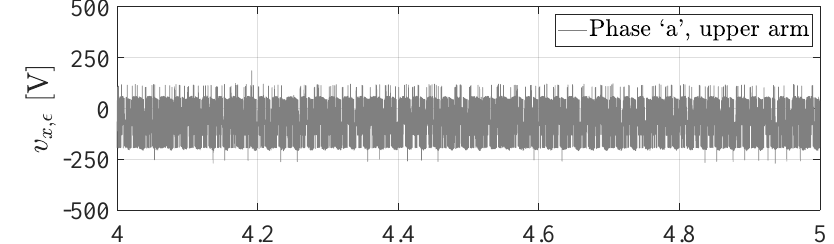
Figure 9. The residual voltage as defined in (6) for the phase a upper arm of the MMC.